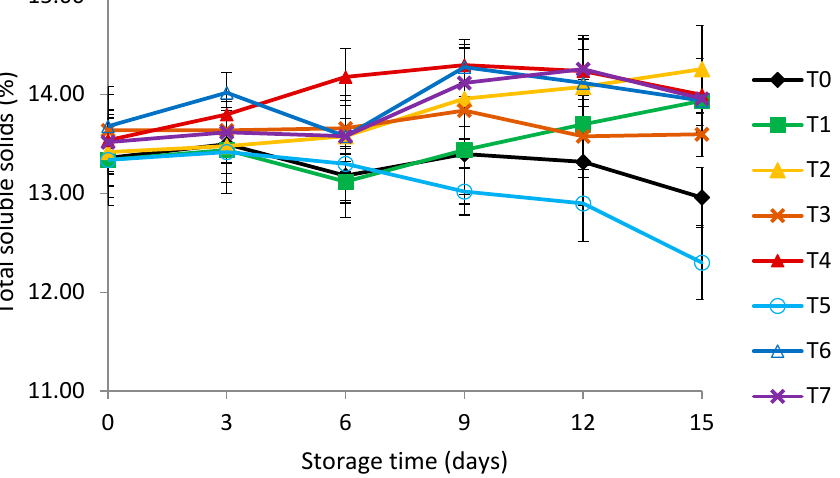
Figure 6. Total soluble solids of control and treated fresh-cut pears stored for 15 days at 8 ± 1 °C. T0—Control; T1—0.2% PE + 1% CaCl 2 ; T2—0.2% PE + 1% CaCl 2 + 0.2% PS; T3—0.2% PE + 1% CaCl 2 + 0.2% PS + 1% N -AC; T4—0.2% PE + 1% CaCl 2 + 0.2% PS + 1% CA + 1% AA; T5—0.2% PE + 1% CaCl 2 + 0.2% SB; T6—0.2% PE + 1% CaCl 2 + 0.2% SB + 1% N -AC; T7—0.2% PE + 1% CaCl 2 + 0.2% SB + 1% CA + 1% AA. Values are the mean of 18 measurements (3 experiments × 6 replicates). Error bars represent ± SD.